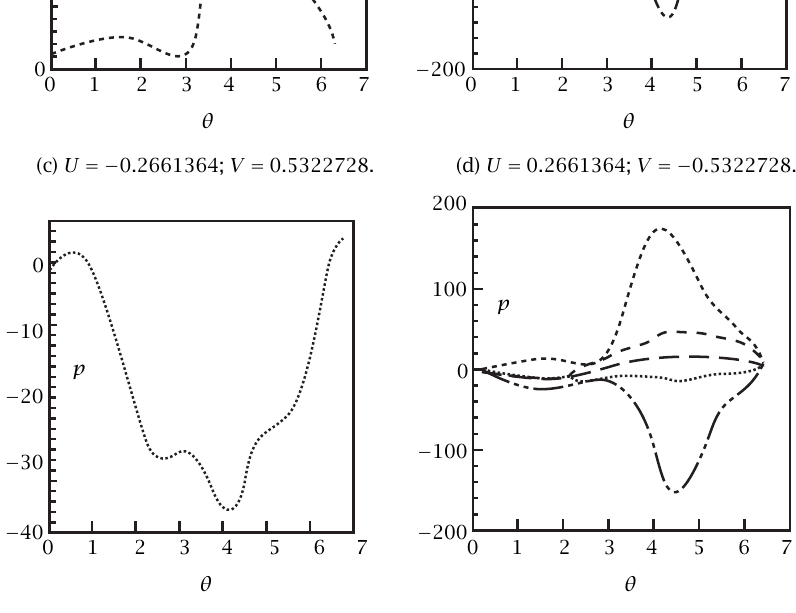
(e) U = − 0 . 2661364; V = − 0 . Figure 22 . The pressure distribution for (cid:9) = 0 . 3; η = − 1 . 0; R M = 0 . 01; α = 0 .